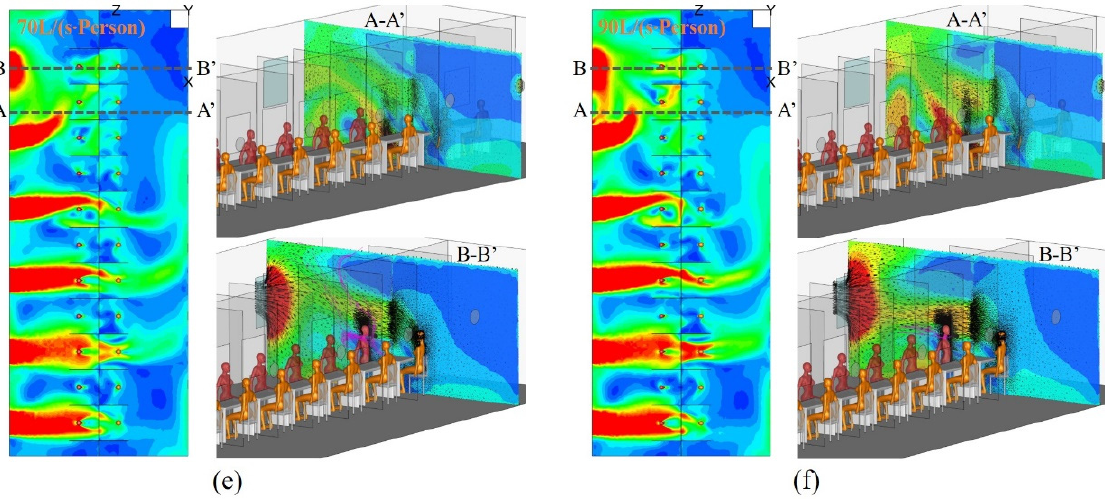
Figure 8. Airflow patterns at the planes of y = 1.1 m, x = 1.09 m, and x = 2.25 m under the SEFV-W with different ventilation rates: ( a ) 10 L/(s ∙ Person); ( b ) 20 L/(s ∙ Person); ( c ) 30 L/(s ∙ Person); ( d ) 50 L/(s ∙ Person); ( e ) 70 L/(s ∙ Person); ( f ) 90 L/(s ∙ Person).